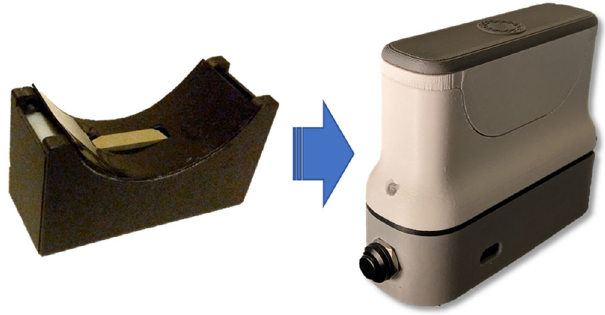
Fig. 6 Evolution of the non-invasive optical device from the exploratory prototype phase to the current production-ready phase. The exploratory and prototype phase devices collected two optical data points whereas the current product collects four optical data points, thus potentially improving the speci fi city of